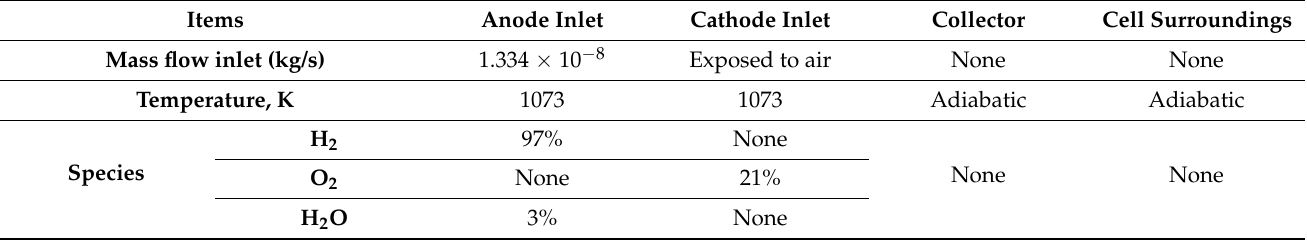
Table 3. Cell boundary and operating